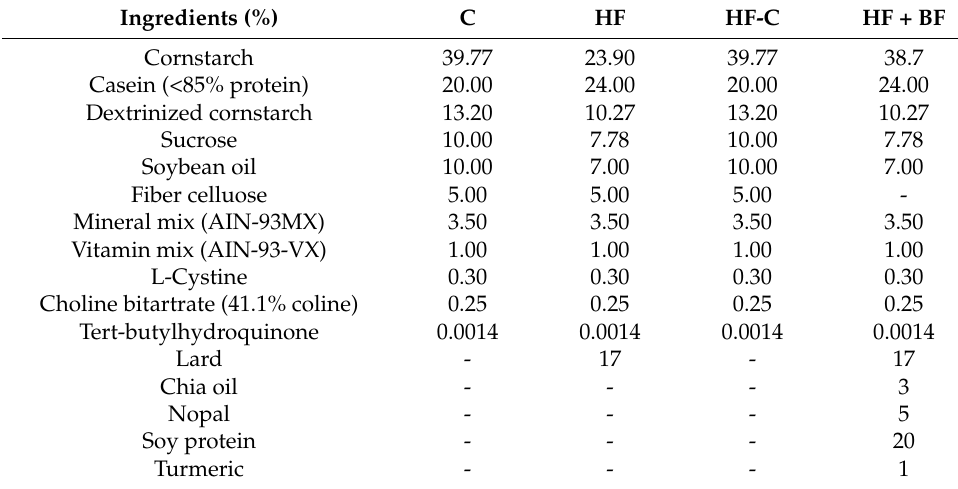
Table A1. Composition of experimental diets (g/100